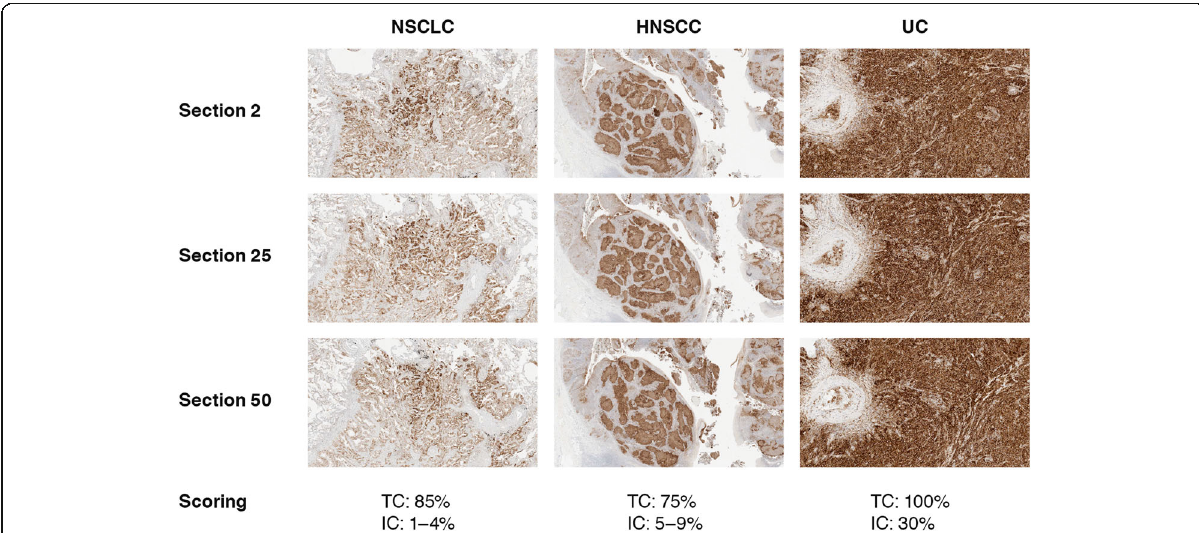
Fig. 2 PD-L1 antibody staining in tumor tissue samples. IHC images of PD-L1 staining (using the VENTANA PD-L1 [SP263] assay with the VENTANA OptiView DAB IHC detection kit on the automated VENTANA BenchMark ULTRA platform) in NSCLC, HNSCC and UC tissue samples (three sections from one block of each). The score given to the PD-L1 TC and IC staining by the pathologist is given under the images. Magnification: NSCLC: ×4; HNSCC: ×2; UC: ×10. HNSCC: head and neck squamous cell carcinoma; IC: tumor-infiltrating immune cells; IHC: immunohistochemistry; NSCLC: non- small cell lung cancer; PD-L1: programmed cell death ligand-1; TC: tumor cells; UC: urothelial carcinoma